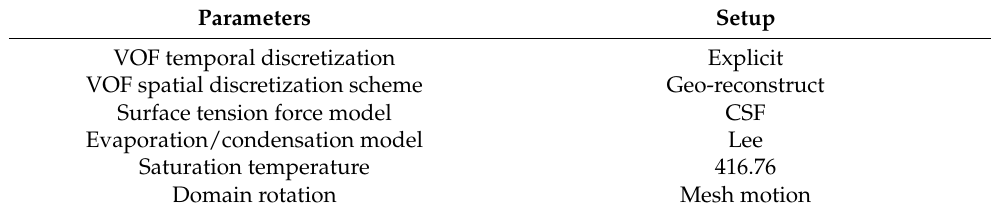
Table 1. Solver Table 1. Solver settings.